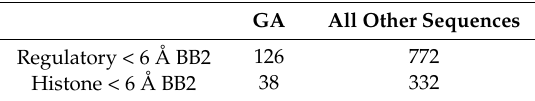
Table 3. An example of contingency table comparing dinucleotides in groups Regulatory < 6 Å and Histone < 6 Å for the BB2/GA association (incidences in Figure 1a,b). The table is constructed to measure the significance of the sequence preferences of the CANA BB2.